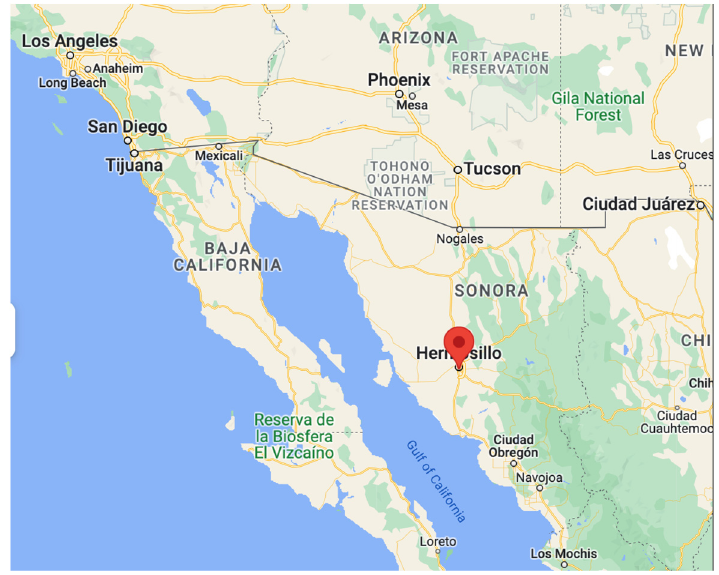
Figure 1. Location of Hermosillo, Mexico (Google Maps).